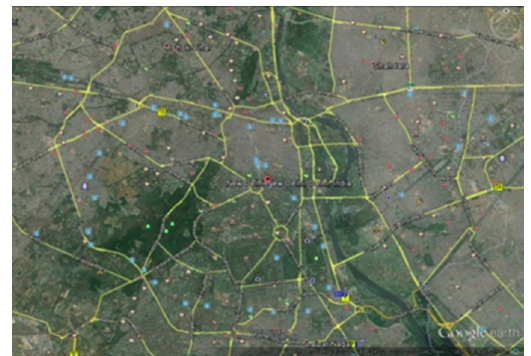
Figure 12. The city map of New Delhi, India.